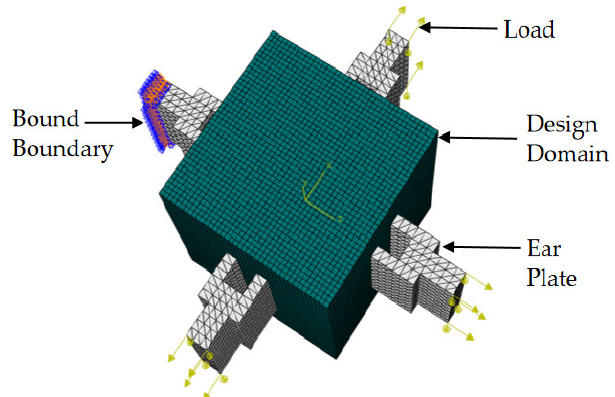
Figure 6. Initial shape and load layout of nodes (the green part is the design domain, the gray part is the ear plate area, the yellow arrow is the combined load of axial force and pressure, and the blue area is the binding boundary).